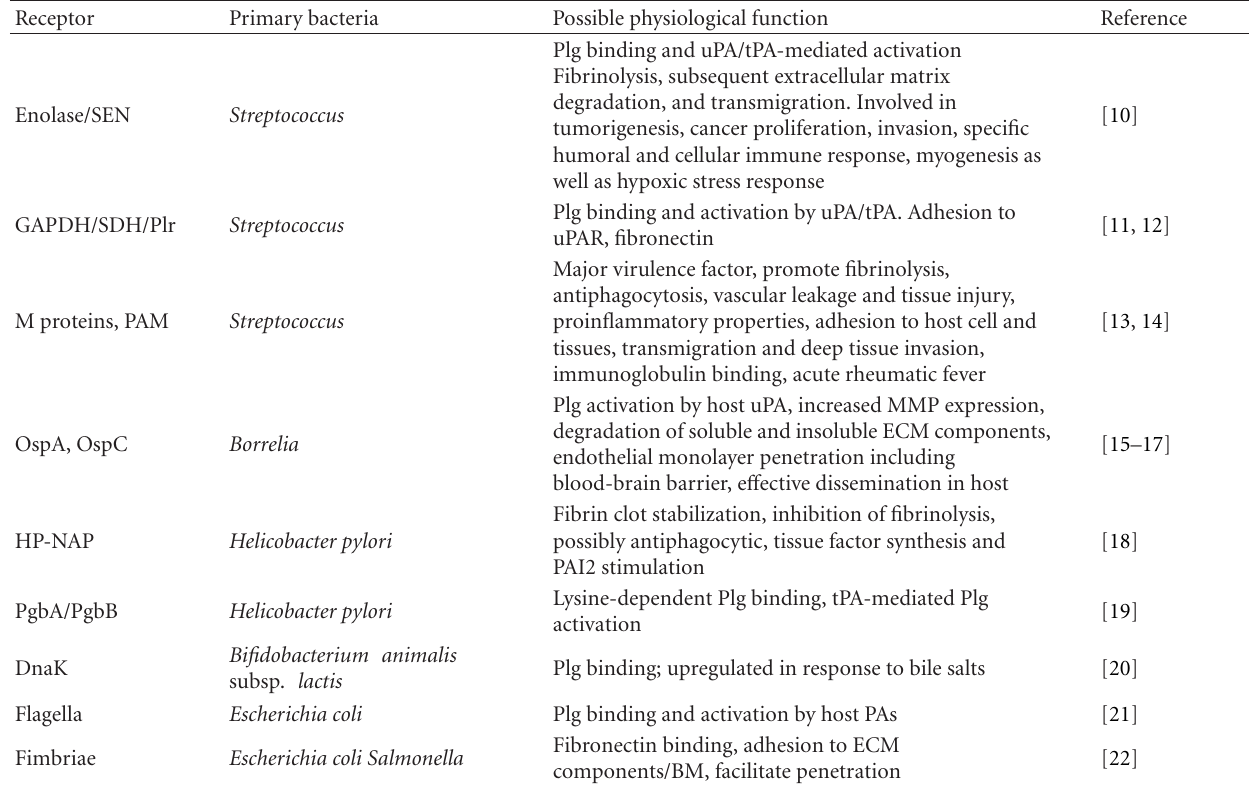
Table 1: Bacterial plasminogen